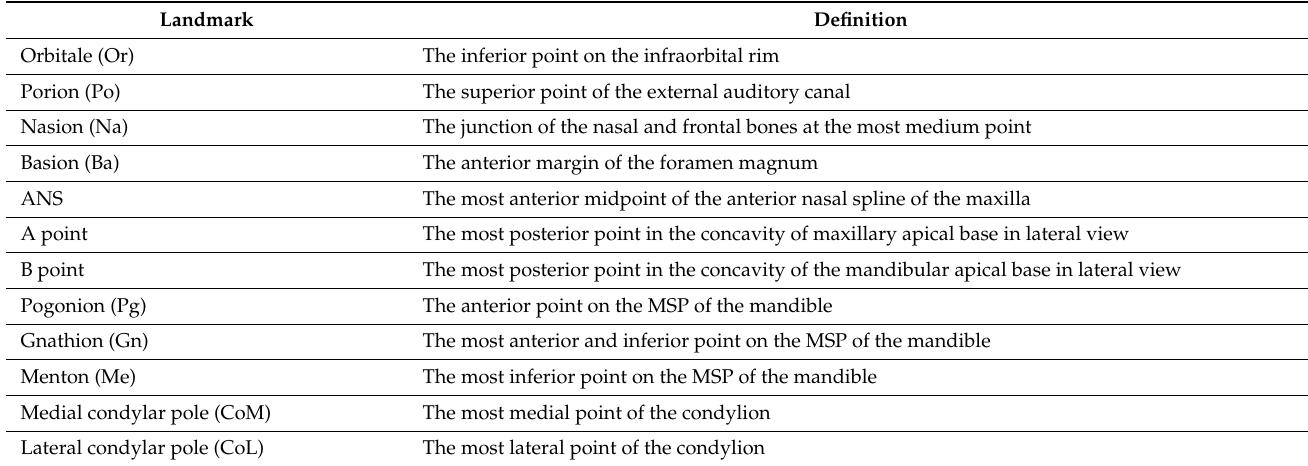
Table 1. Definition of 3D dentoskeletal landmarks and variables for